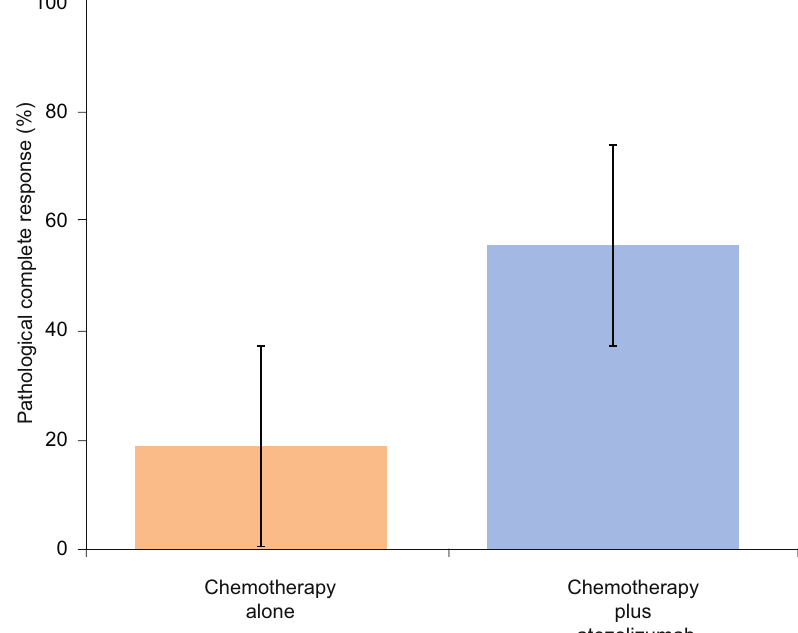
Fig. 2 Pathological complete response according to study arm. Arm A (orange bar) represents patients randomly assigned to chemotherapy alone, Arm B (blue bar) represents patients assigned to atezolizumab plus chemotherapy. Error bars represent the 95% con fi dence interval of pCR